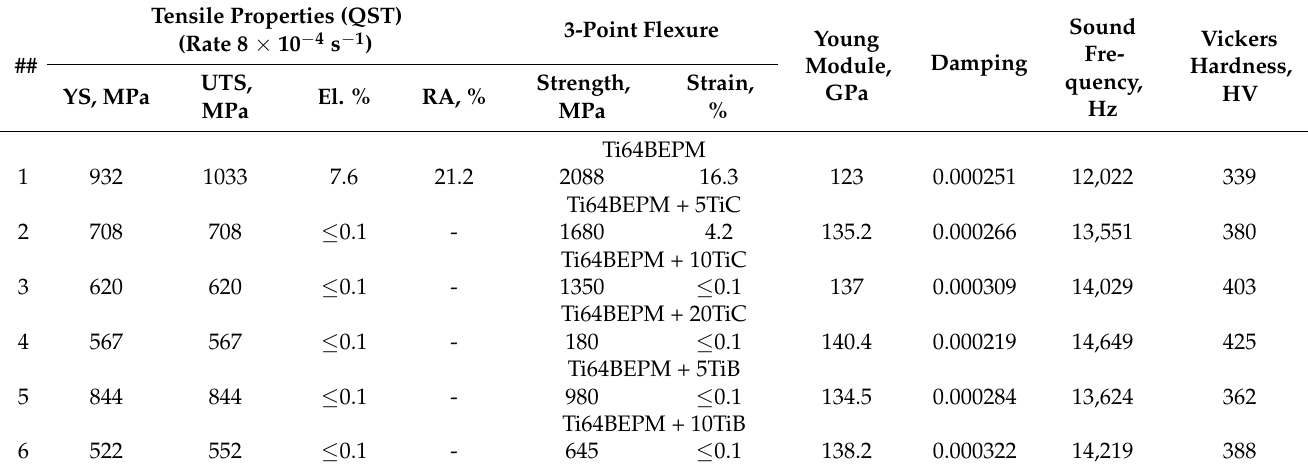
Table 2. Mechanical Properties of the Obtained